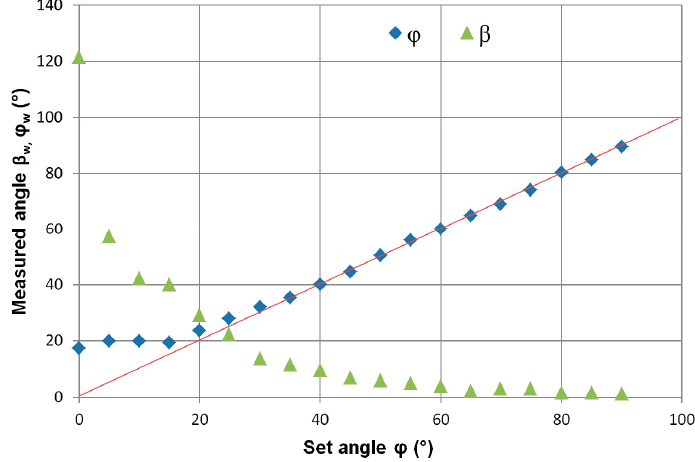
Figure 6. Dependence of the determined values of angles ϕ w and β w on the set angle ϕ . Set ME8 standard coordinates ( x 0 , y 0 , z 0 ) = (0, 0, 140) mm.